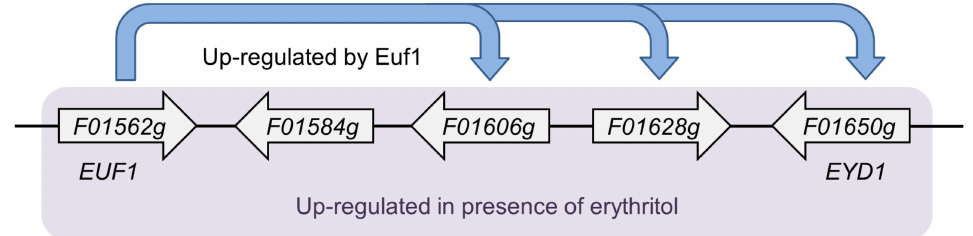
Figure 1. Cluster of genes involved in erythritol utilization located on chromosome F in Y. lipolytica CLIB122 genome